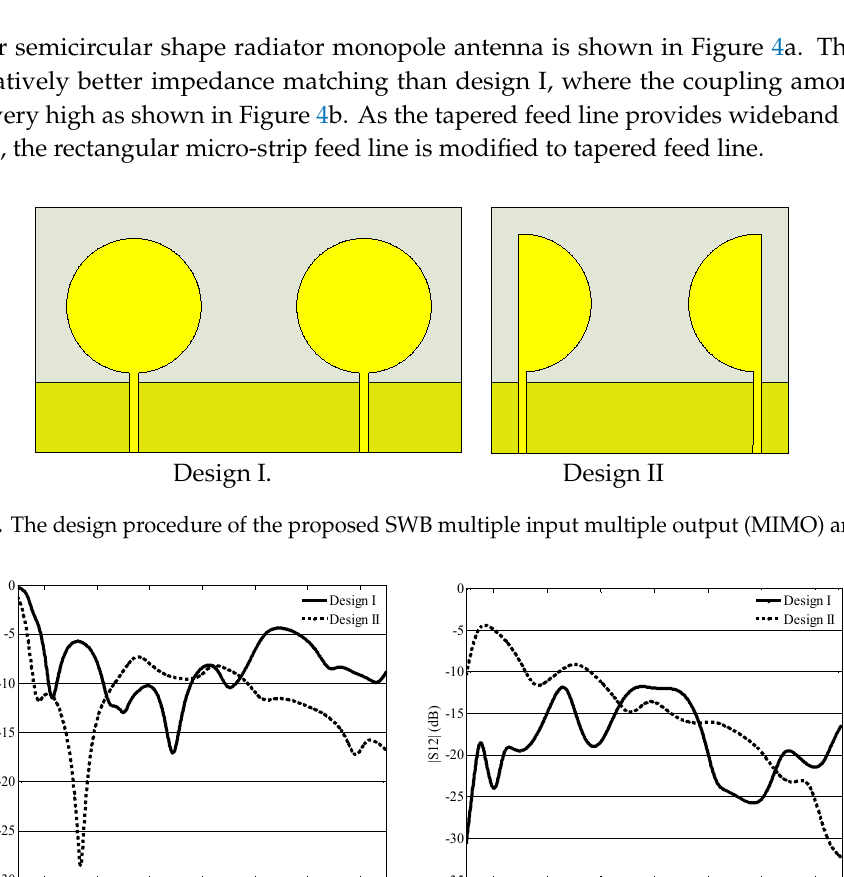
Figure 3. The design procedure of the proposed SWB multiple input multiple output (MIMO) antenna.